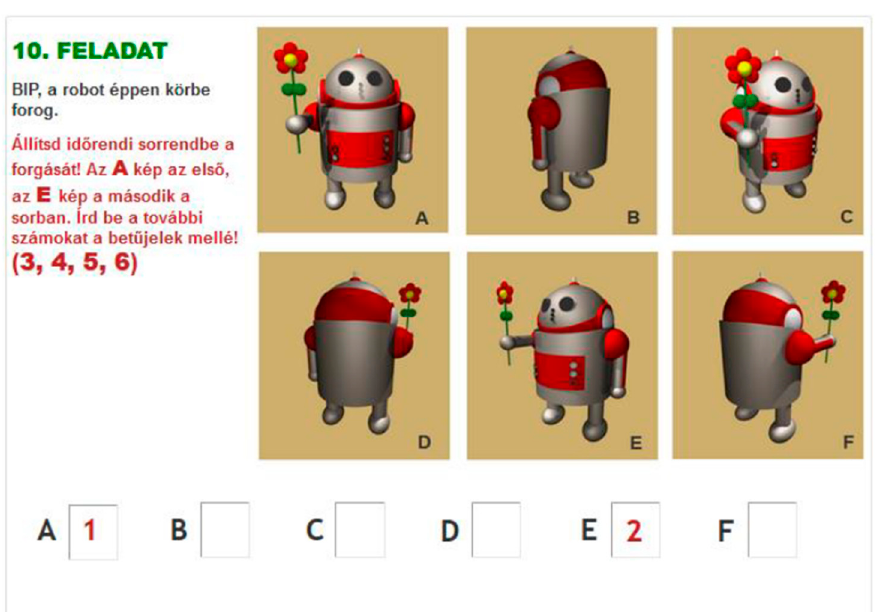
Figure 5. The assignment of Task 7.